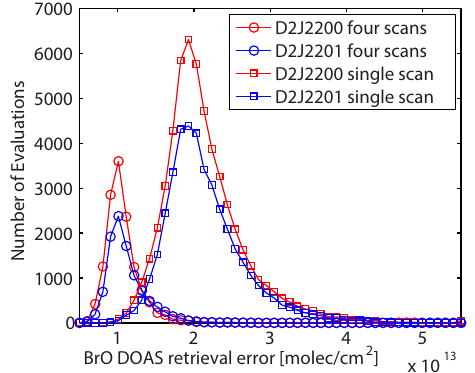
Figure 8. The BrO DOAS fit errors for both instruments whose data are presented in this study. The plot shows the results for spectra from single scans and for spectra co-added from four consecutive scans. The latter have a 50% lower BrO DOAS fit error than single